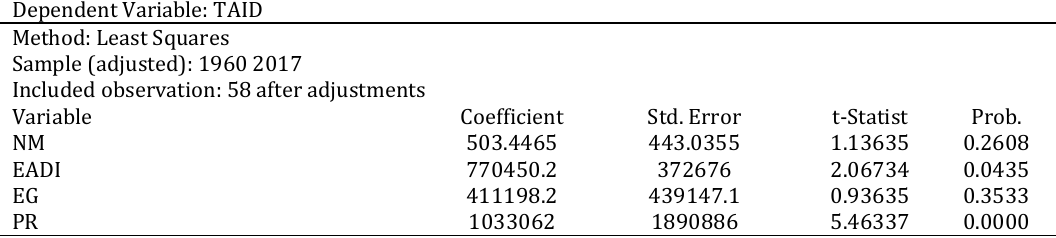
Table 14: Estimation of Total Bilateral aid received model Dependent Variable: TAID